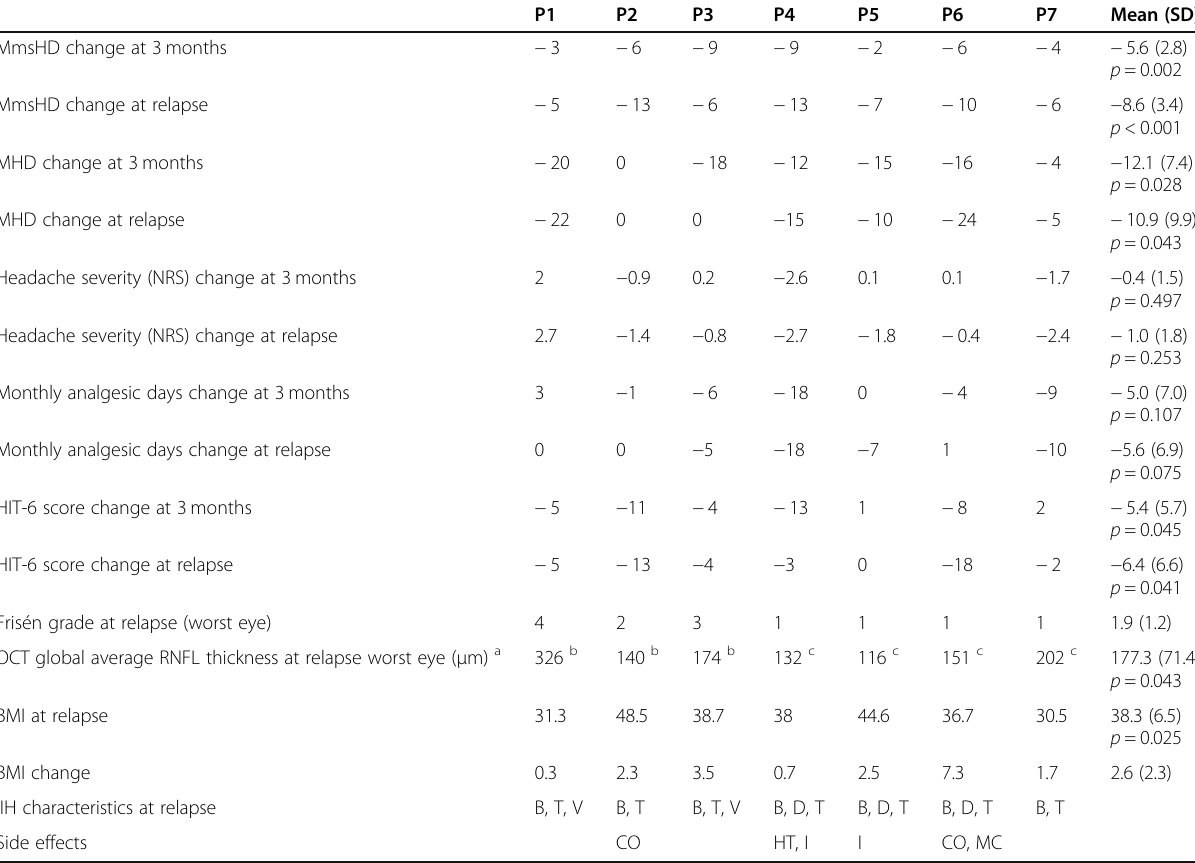
Table 2 Patient clinical